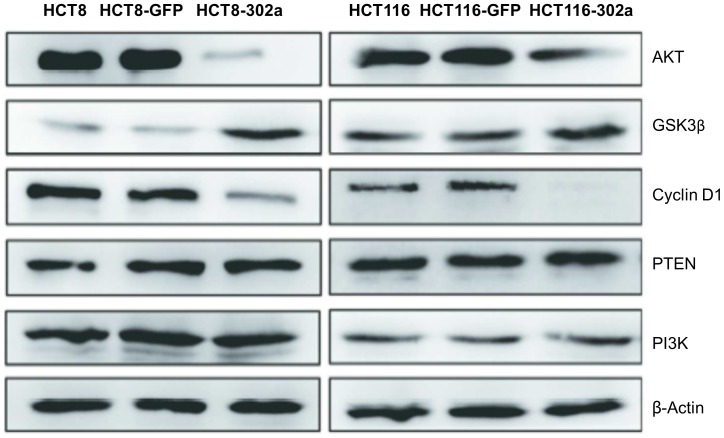
Overexpression of miRNA-302a in colon cancer cells triggers alterations in the AKT-GSK3β-cyclin D1 signaling pathway.Western blot analyses showed downregulated AKT and cyclin D1 levels, and upregulated GSK3β levels in miRNA-302a overexpressing HCT8 cells. PTEN and PI3K levels were not affected.